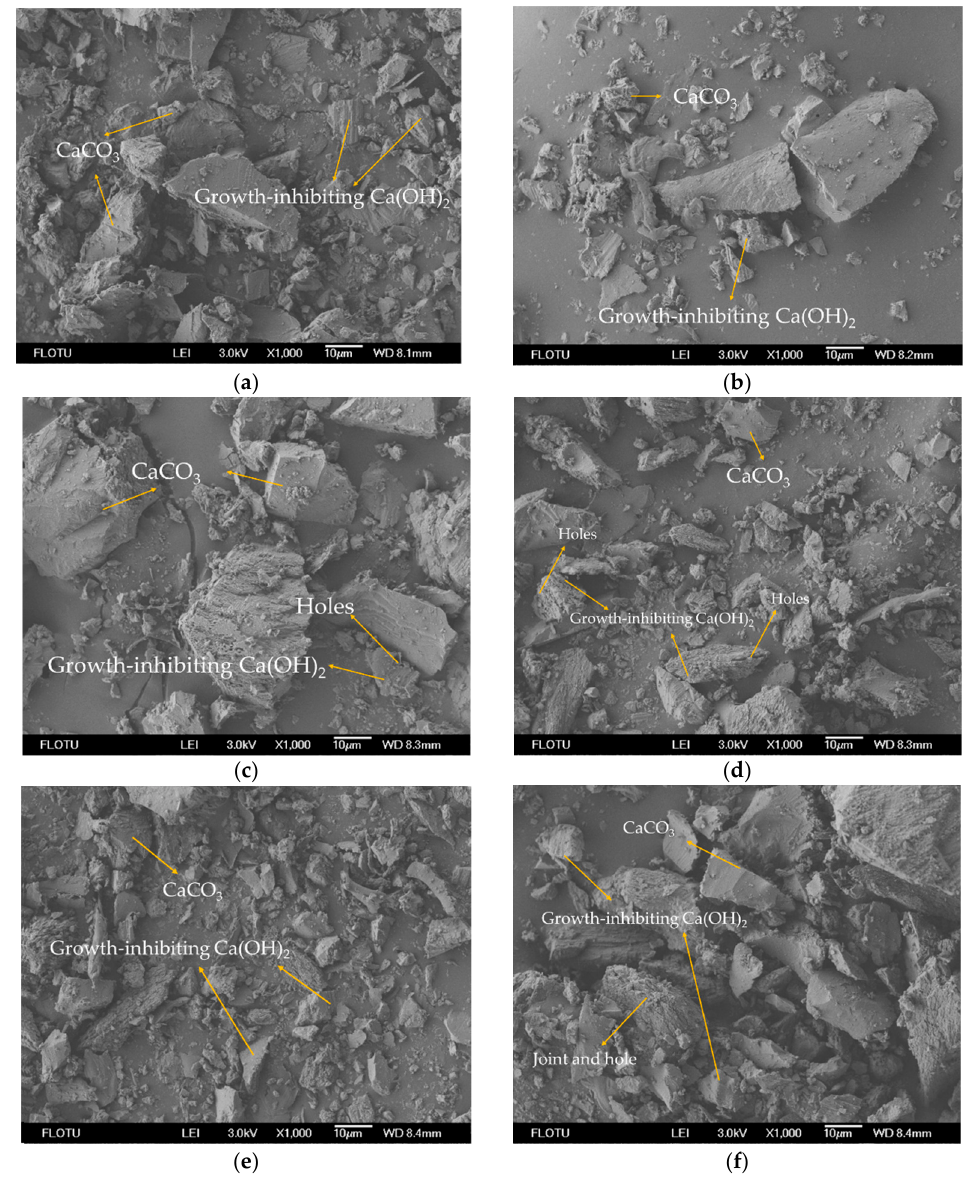
Figure 4. SEM morphology image (×1000) of solid sediments: ( a ) #1 sediment; ( b ) #2 sediment; ( c ) #3 sediment; ( d ) #4 sediment: ( e ) #5 sediment; ( f ) #6 sediment. sediment; ( d ) #4 sediment: ( e ) #5 sediment; ( f ) #6